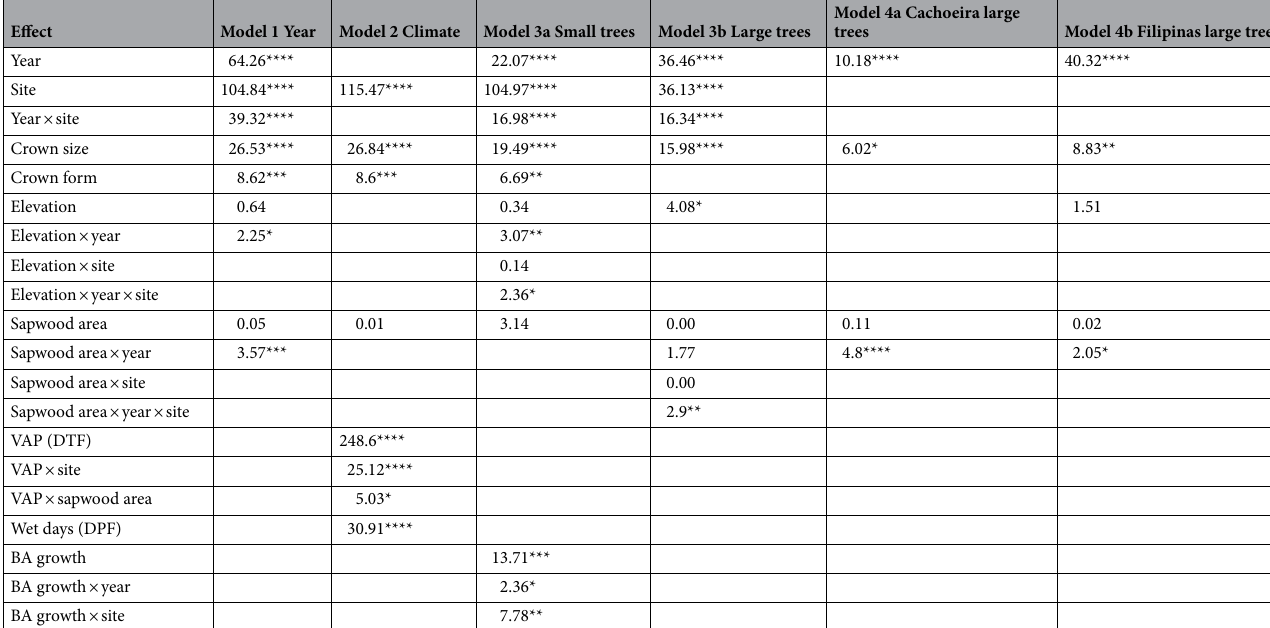
Table 2. F-values and statistical significance from models of annual production, using (1) year as the indicator of annual conditions, and (2) climate variables instead of year, (3a) small trees only (< 100 cm DBH), (3b) large trees only (≥ 100 cm), (4a) large trees in Cachoeira, and (4b) large trees in Filipinas. Models 3–5 use year as the indicator of annual conditions (Full model statistics available in SI Table S1). VAP vapor pressure,